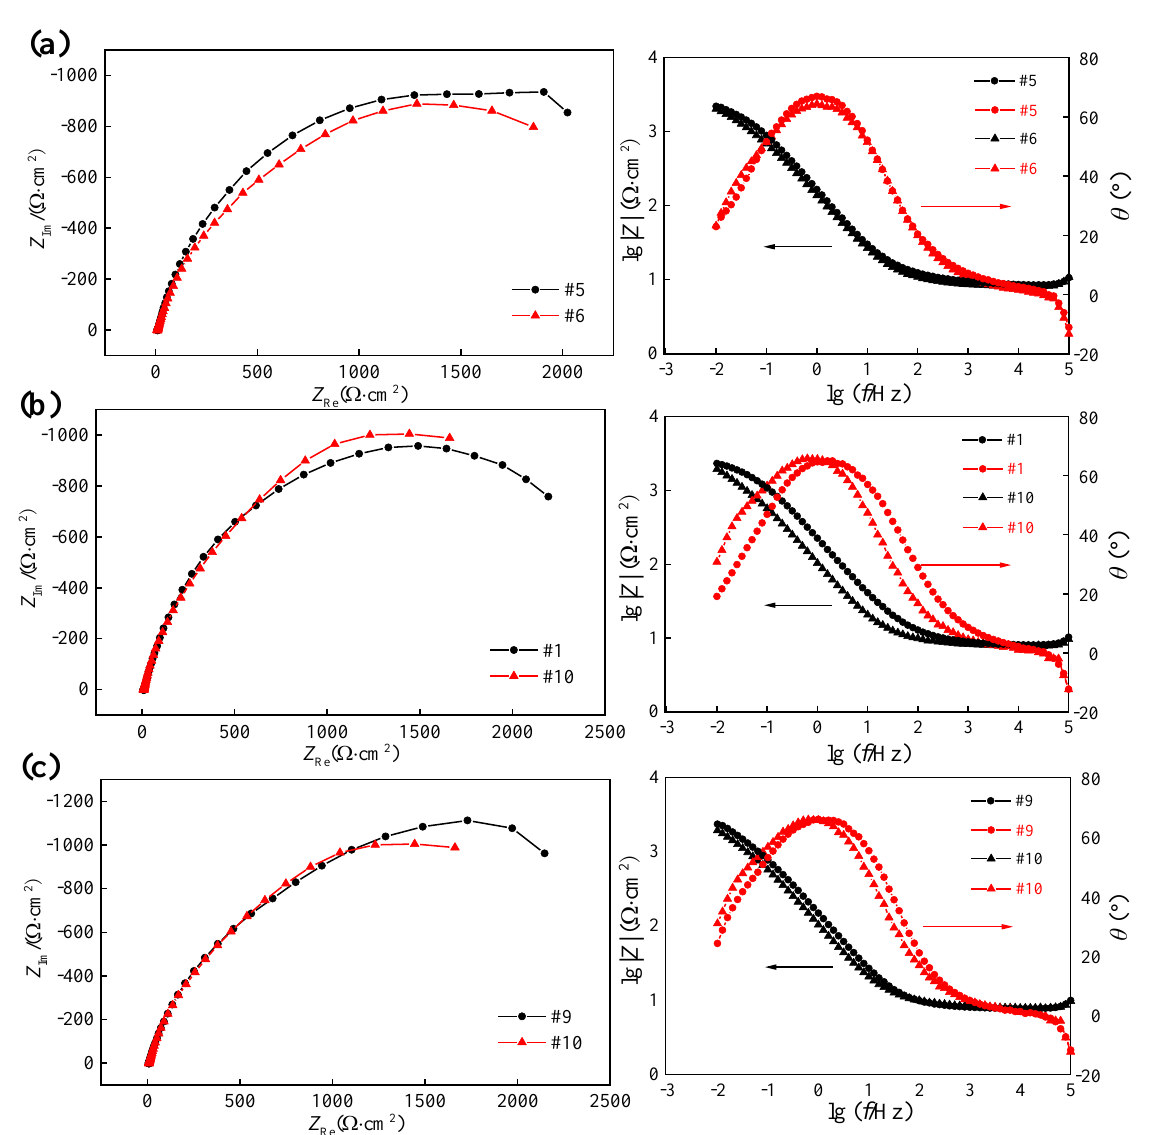
Figure 15. Nyquist plots and Bode plots of samples obtained in comparative experiments: ( a ) #5 and #6, ( b ) #1 and #10, and ( c ) #9 and #10.